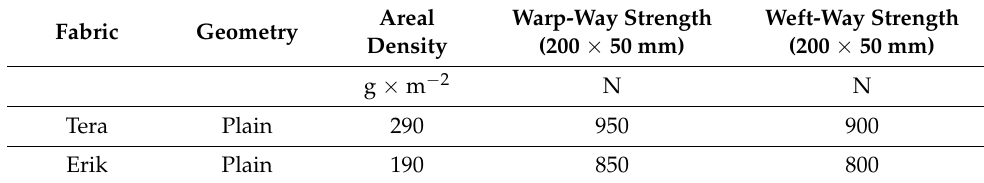
Table 3. Reinforced fabric characteristics [46].